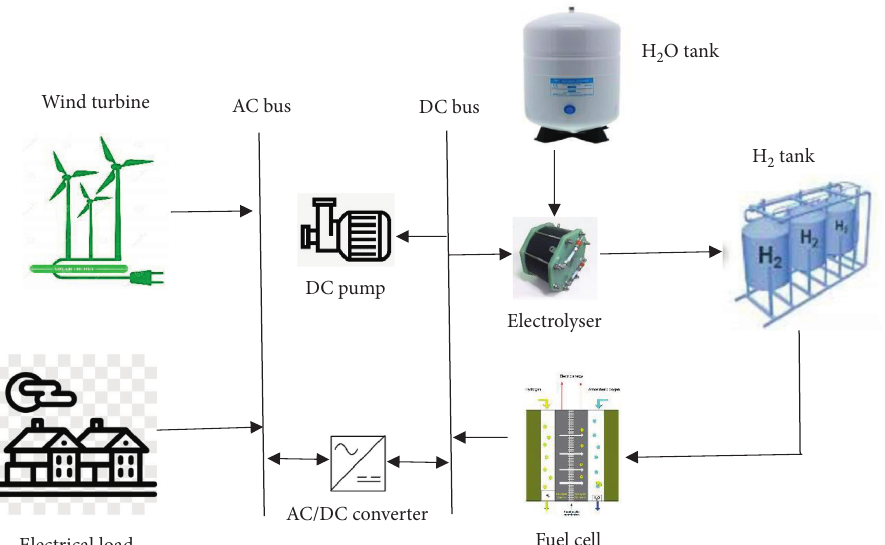
Figure 1: HRES scenario 1 block diagram.